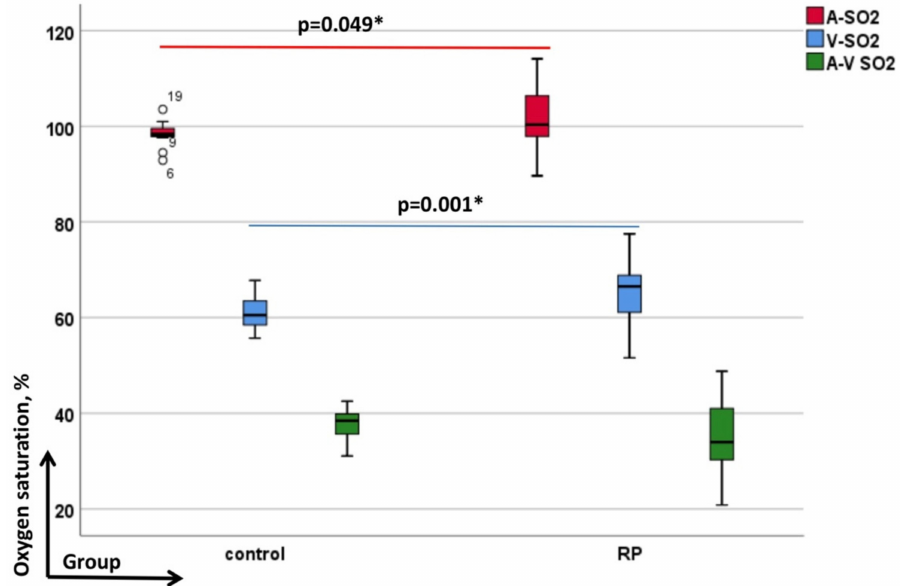
Figure 5. Depicts retinal vessel oxygen saturation data of arterioles (A-SO 2 , red-colored) venules (V-SO 2 , blue-colored) and their corresponding difference (A-V SO 2 , green-colored). In each graph the groups as labelled on the y-axis (from left to the right: controls and retinitis pigmentosa (RP)) and the evaluated diameter-parameters—on the x-axis. All significant p -values are given in bold with asterisk and the numbered circles the